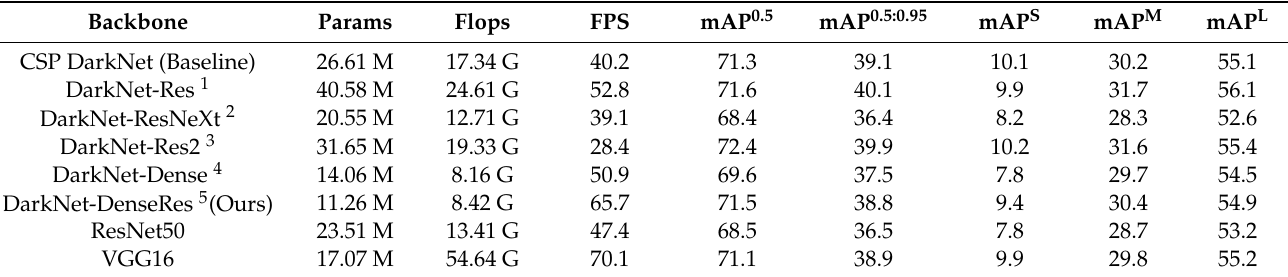
Table 6. Results of comparative experiment for different backbones.